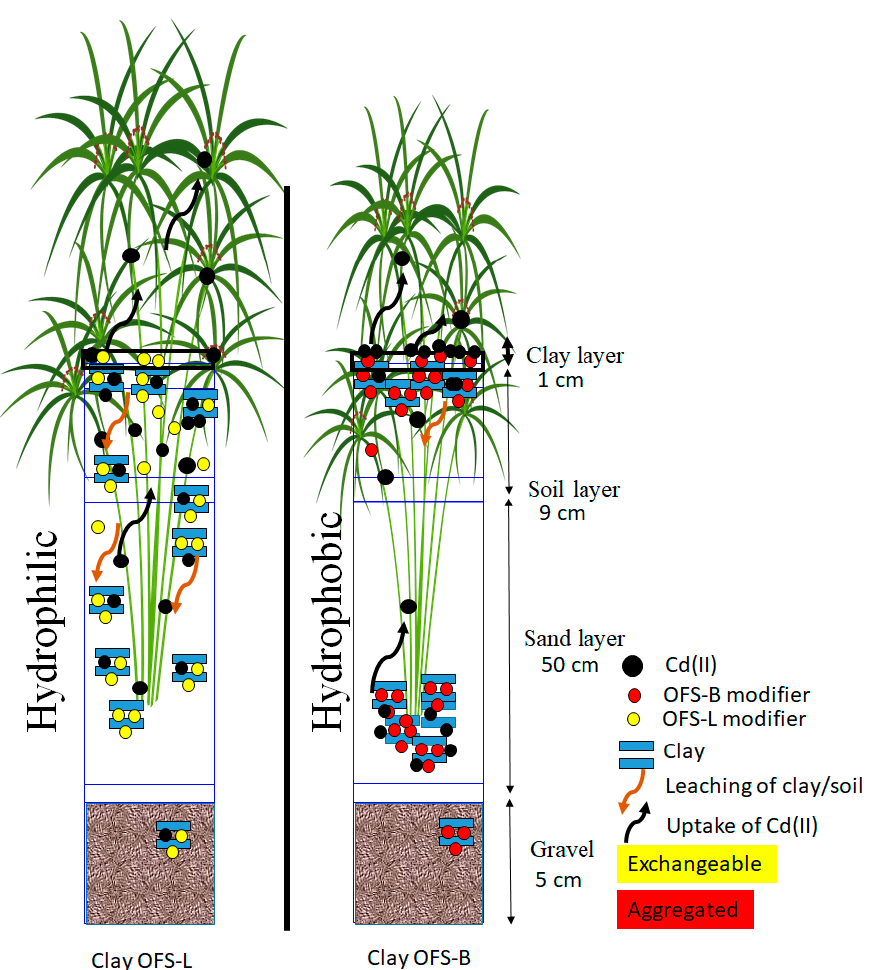
Figure 8. Schematic illustration of movement of Cd (II) in Clay OFS-L ( left ) and Clay OFS-B ( right ) incorporated bioretention system.